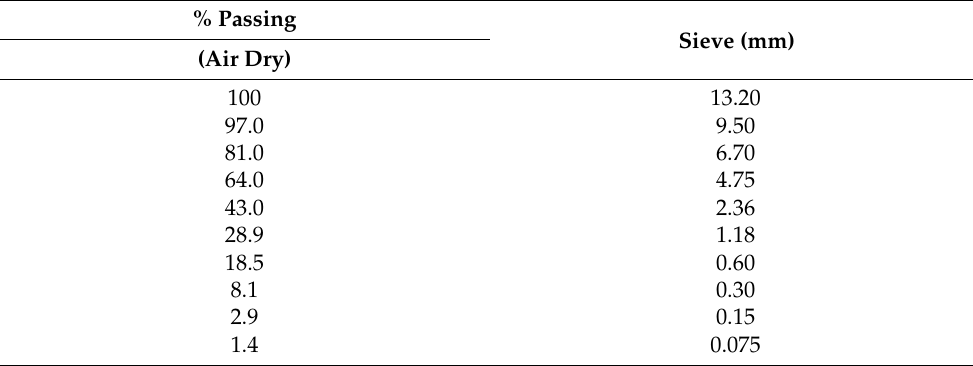
Table 1. RAP particle size distribution